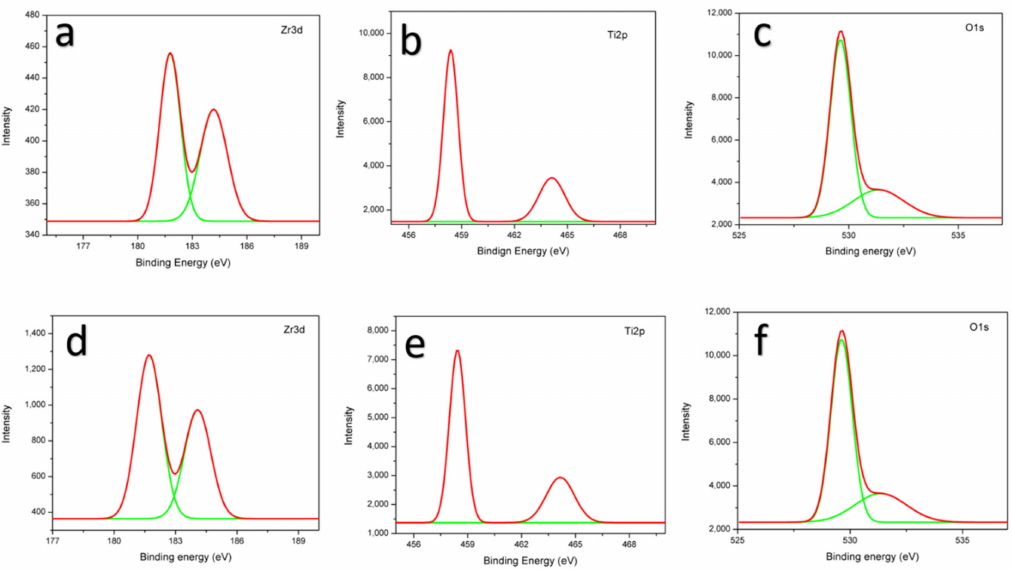
Figure 6. XPS spectra of TZr-1 ( a – c ) and TZr-10 ( d – f ) for Zr 3d, Ti 2p and O 1s. Table 2. Superficial atomic composition of Ti 2p, Zr 3d and O 1s in TZr samples determined by XPS.